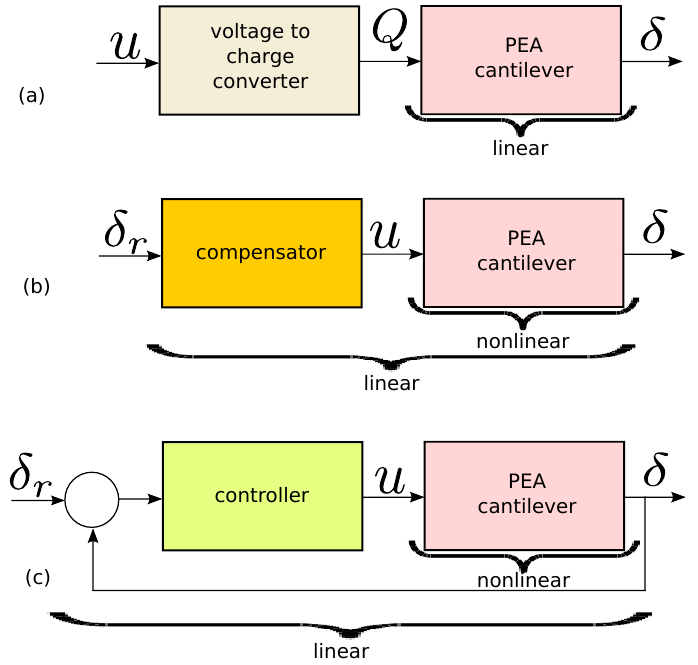
Figure 3. Displacement control of a PEA actuator. ( a ) Charge control considering that relationship of the PEA’s carge and displacement are linear; ( b ) Feedfoward control structure via an hysteresis/creep compensator; ( c ) Feedback control structure based on the displacement